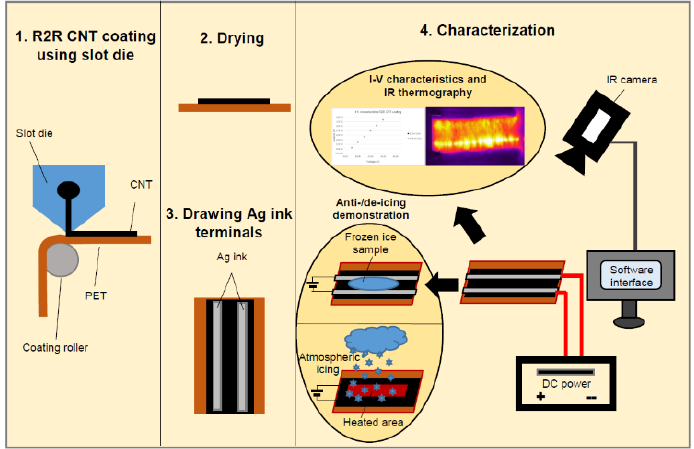
Figure 11. Scheme of obtaining CNT films by the roll-to-roll method and their testing. Reprinted with permission from [79].